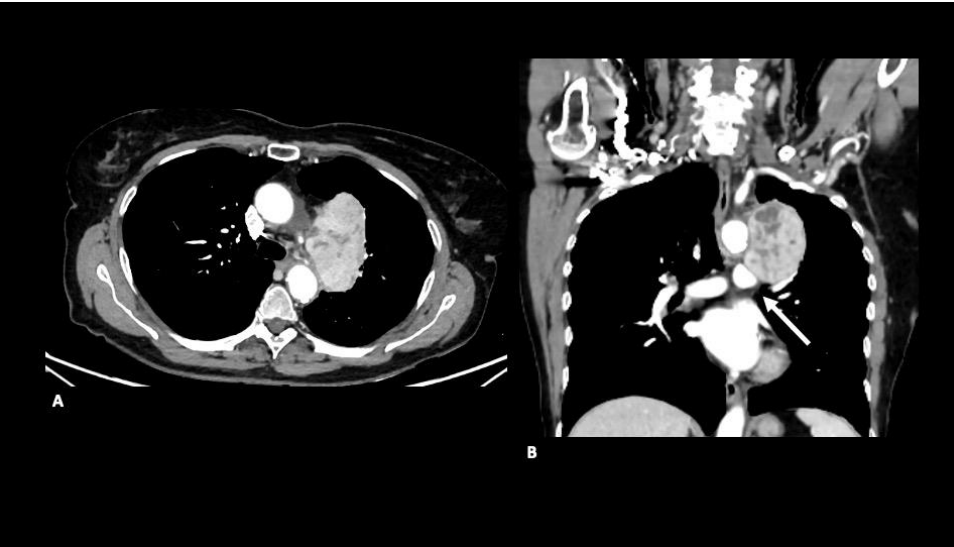
Figure 1. Axial ( A ) and coronal ( B ) contrast-enhanced CT images show a large, heterogeneous mediastinal mass that extends into the aortopulmonary window and compresses the left pulmonary artery. Note the large size and the heterogeneous attenuation, standard features of leiomyosarcoma. After multidisciplinary consultation, a CT-guided core needle biopsy of the mass was